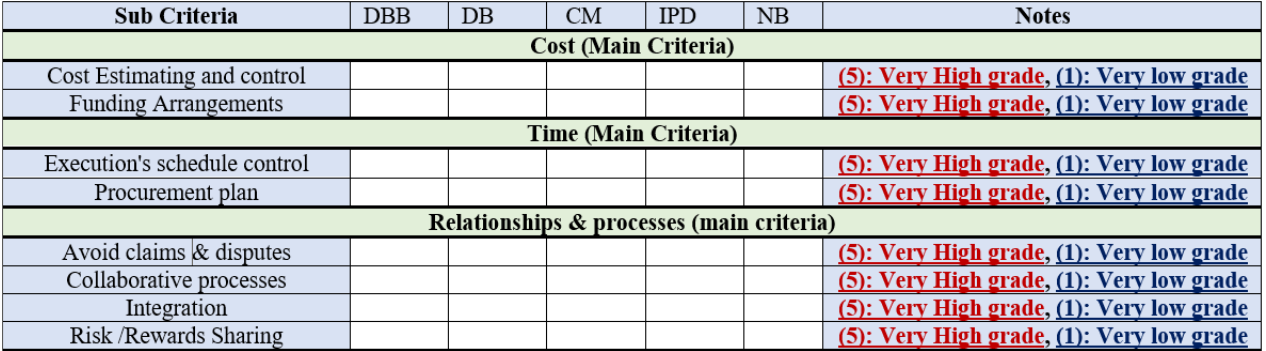
Figure 5. Instructions included to guide the participants in part 3 of the questionnaire .